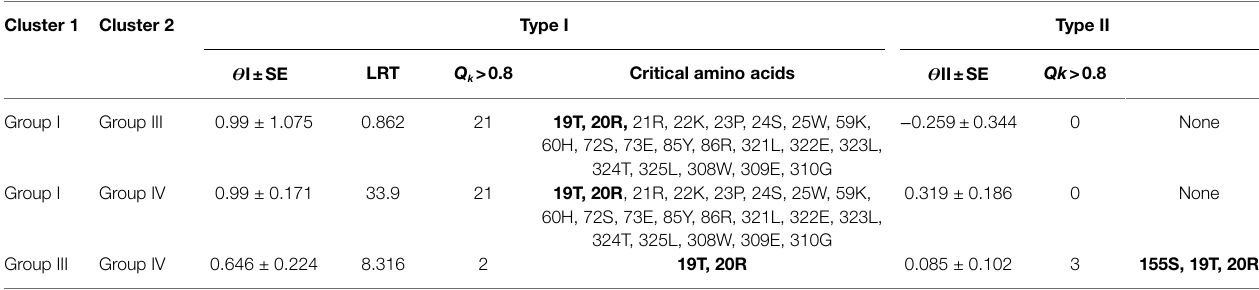
TABLE 2 | Functional divergence analysis between different groups of the BnaBZR gene family. Cluster 1 Cluster